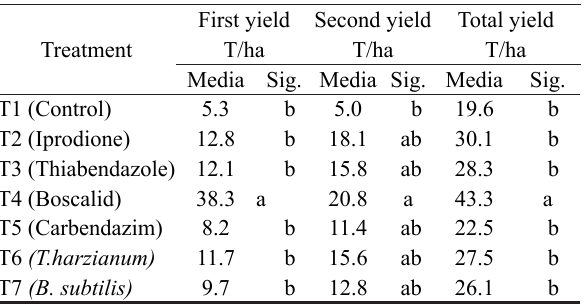
Table 7: Test for first and second quality yields and total yield with different fungicide treatments with broccoli addition. (alfa=0.05). Treatment